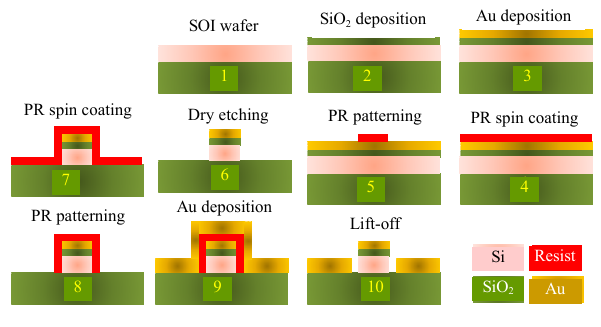
Fig. 9 Proposed fabrication steps of the